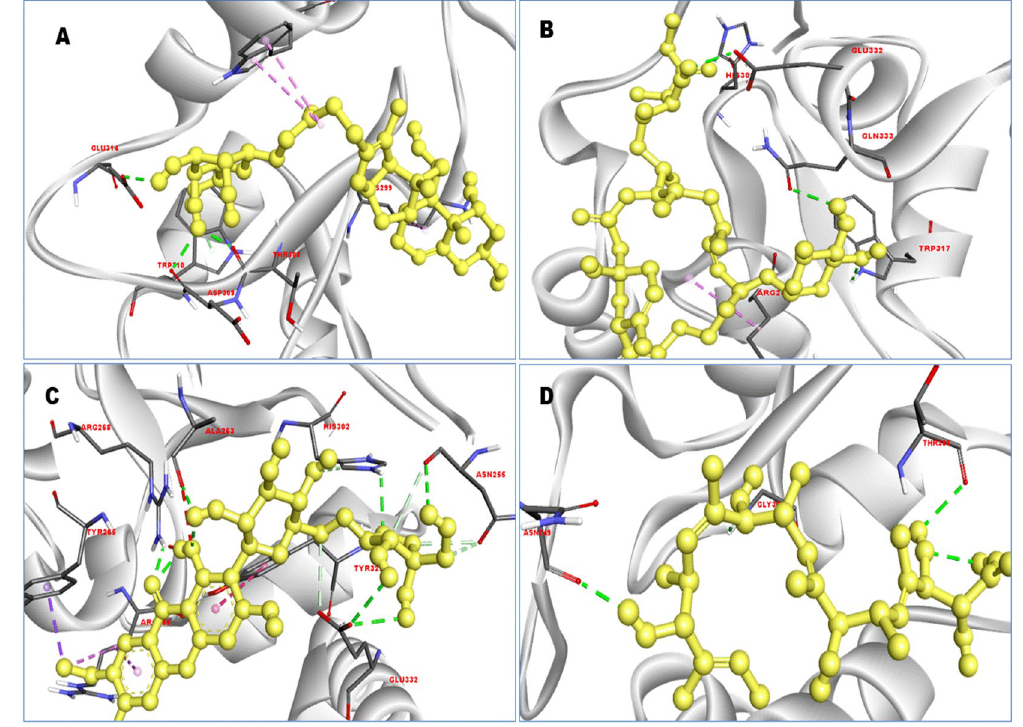
Figure 5. 3D interaction between the protein–ligand complex. Here, figure ( A ) ZINC77257307, ( B ) ZINC1070004335, ( C ) ZINC247950187, and ( D ) ZINC107434573 showing the ligand contact with the protein XIAP after molecular